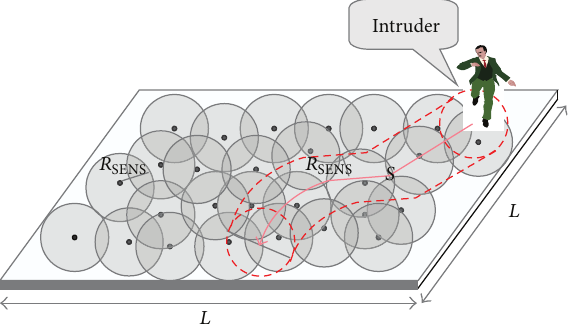
Figure 3: A simple intrusion scenario: an intruder starts from a random point in the WSN and moves in a random fashion and sweeps the surface area 𝑆 following a trajectory 𝑙